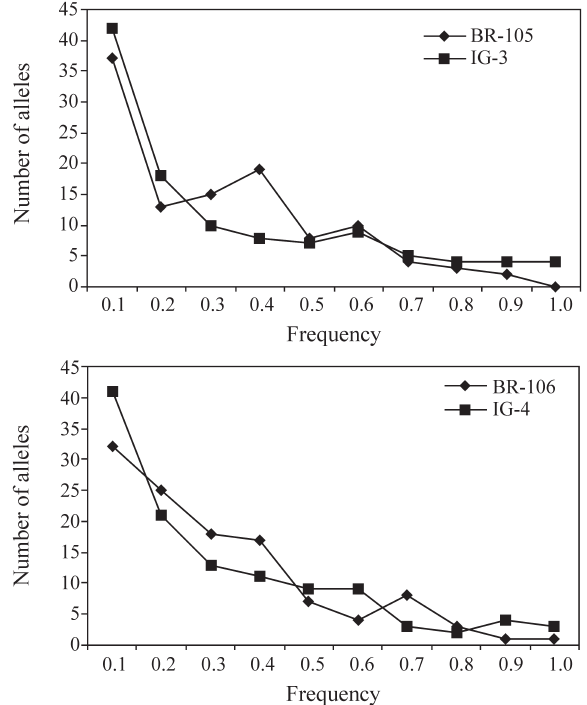
Figure 2 - Allele frequency distribution in the maize populations BR-105 and BR-106 and their synthetics IG-3 and